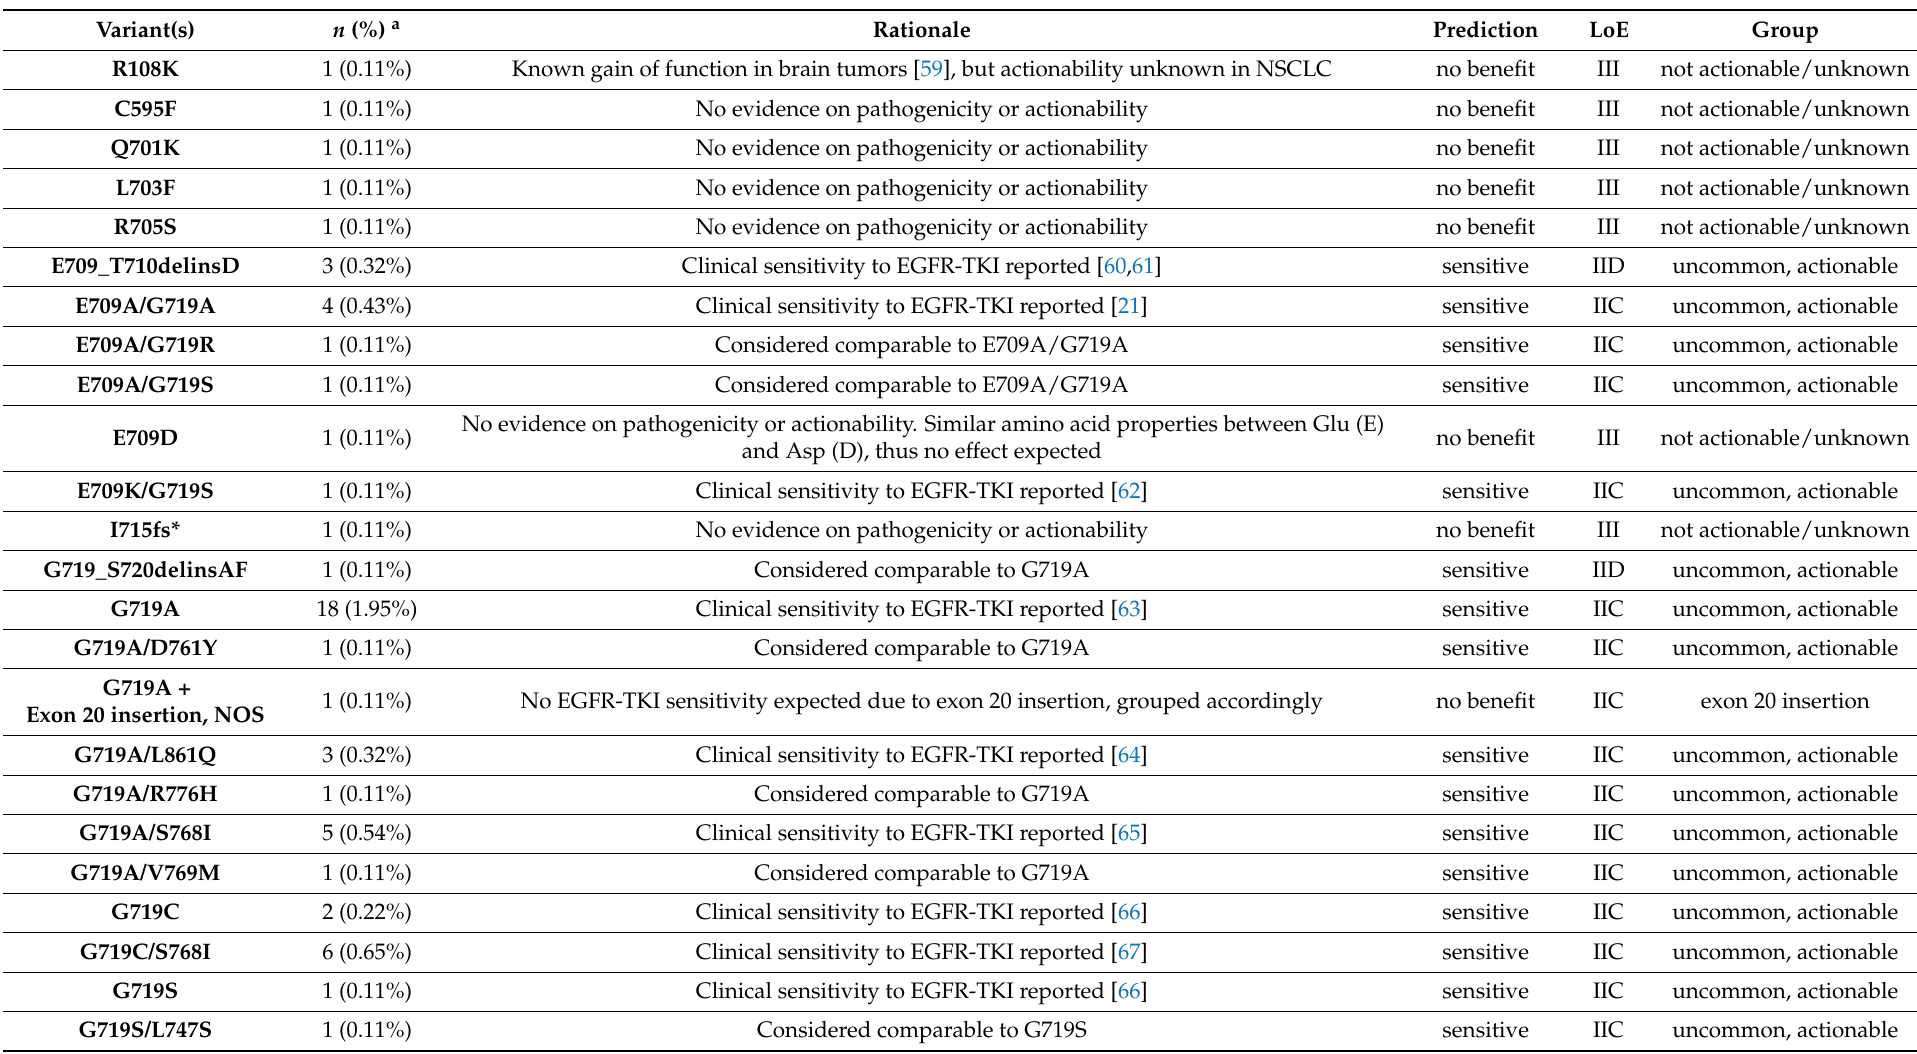
Table 4. Rationale for classification of expected first- and second-generation EGFR-TKI sensitivity for EGFR variants reported in the Dutch population in 2013, 2015 and